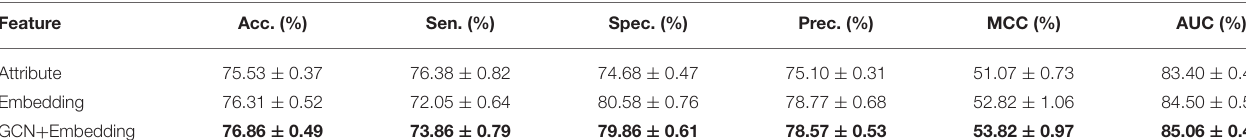
TABLE 2 | Comparison of different feature using Random Forest Classifier under five-fold cross-validation.